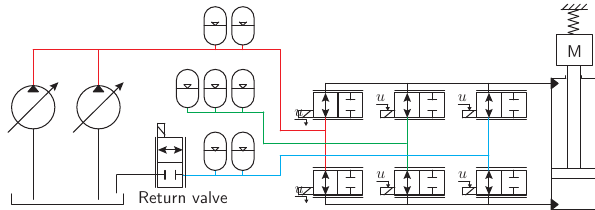
Figure 1: MPL concept capable of recovering potential energy and reducing throttling